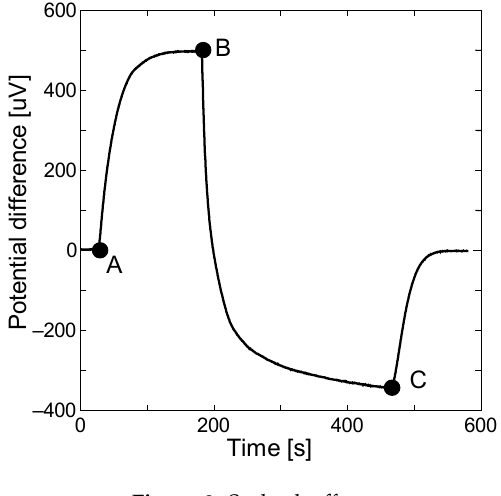
Figure 8. Seebeck effect. Figure 8. Seebeck e ff